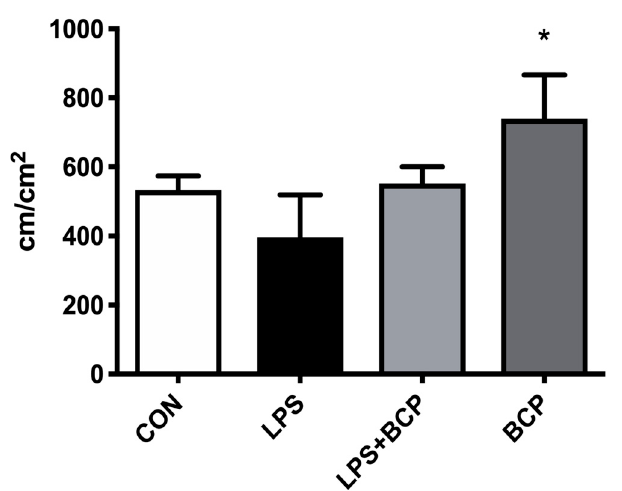
Figure 8. Capillary perfusion quantified through FCD within the bladder microcirculation of female BALB/c mice for the following groups: control (CON; n = 5), LPS-induced IC (LPS; n = 5), IC treated with oral BCP (100 mg/kg, LPS + BCP; n = 5), healthy animals administered oral BCP (100 mg/kg, BCP; n = 5). All groups were pretreated with olive oil gavage, with the treatment groups receiving BCP dissolved in olive oil . Saline and LPS were administered via intravesical instillation. Data presented as mean ± SD. * p < 0.05 vs LPS.